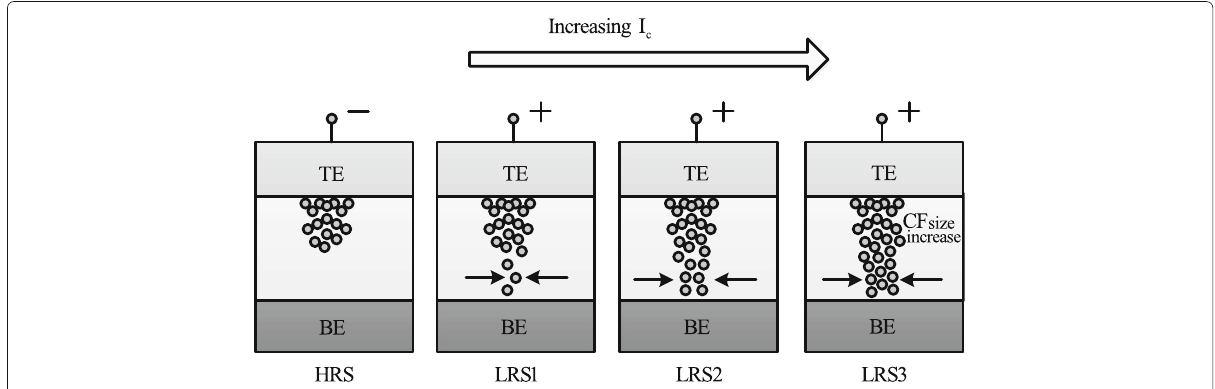
Fig. 12 Schematic illustration of multiple resistance states in RRAM cell obtained by varying compliance current ‘ I cc ’ [98]